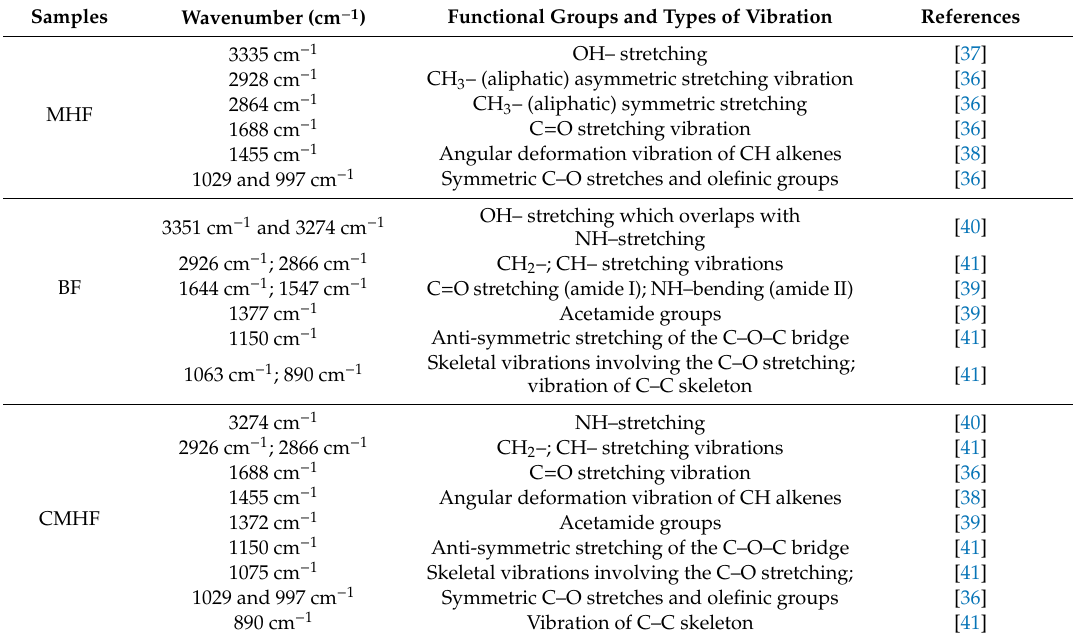
Table 3. FTIR analysis of MHF, BF, and CHMF.